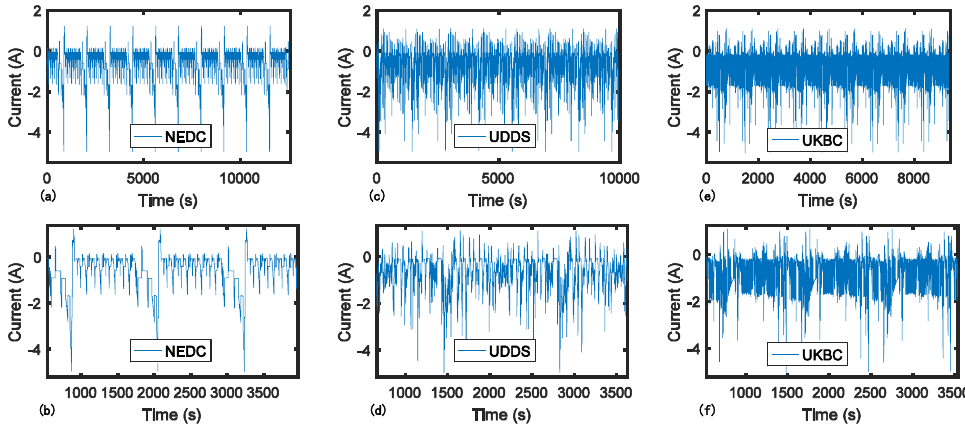
Figure 4. Current profiles and zoom figure of ( a , b ) NEDC, ( c , d ) UDDS, and ( e , f ) UKBC.